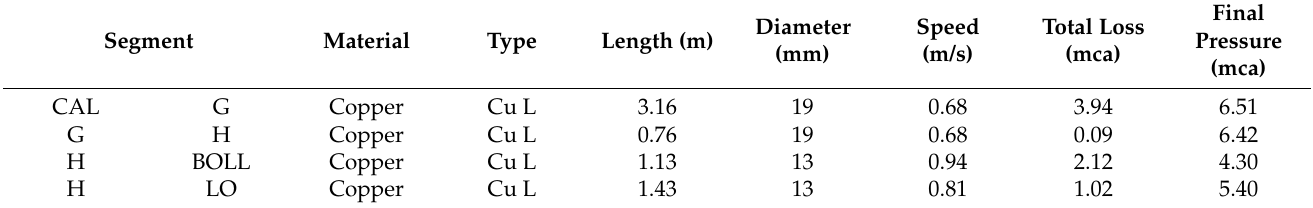
Table 21. Summary table for hot potable water system losses for type 2 commercial